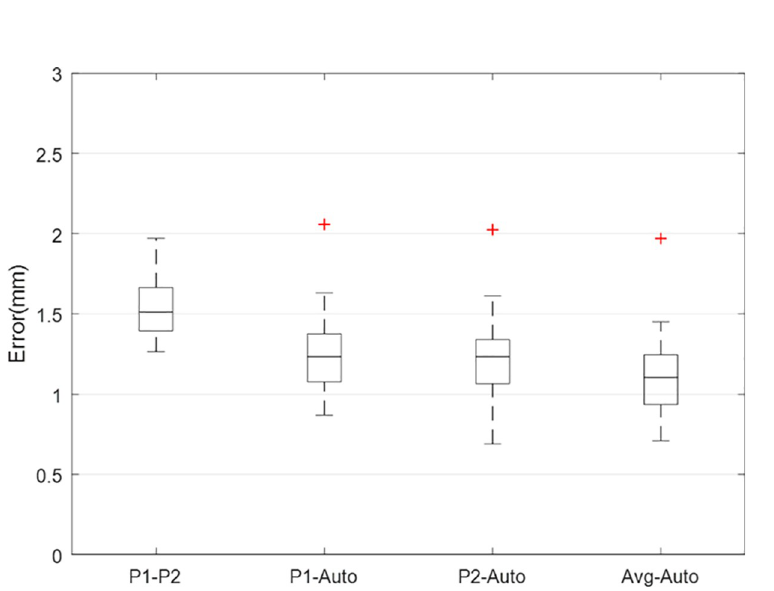
Fig 4. Boxplot chart of average landmark error between manual indications and automatic landmarks. The plot shows the error between the average of manual indications of user 1 and user 2 (P1-P2), the error between the average of manual indications of user 1 and the algorithm (P1-Auto), the error between the average of manual indications of user 2 and the algorithm (P1-Auto), and the error between the average of manual indications of both users and the algorithm